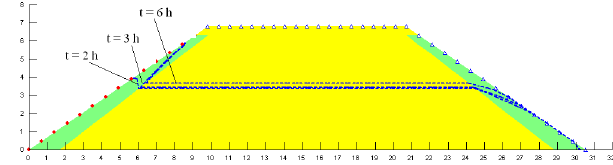
Figure 8 - Mesh and boundary conditions adopted for the seepage analysis. Green elements indicate low-permeability soil strata along the slopes; yellow elements represent rockfill. Red circles indicate nodes with a prescribed hydraulic head; blue empty triangles indicate free draining nodes. The inclined red line in the downstream toe area indicates the line of numerical monitoring of the pore pressure (see Figure 12); the horizontal blue line in the downstream toe area represents the line of numerical monitoring of the hydraulic gradient (see Figure 13).